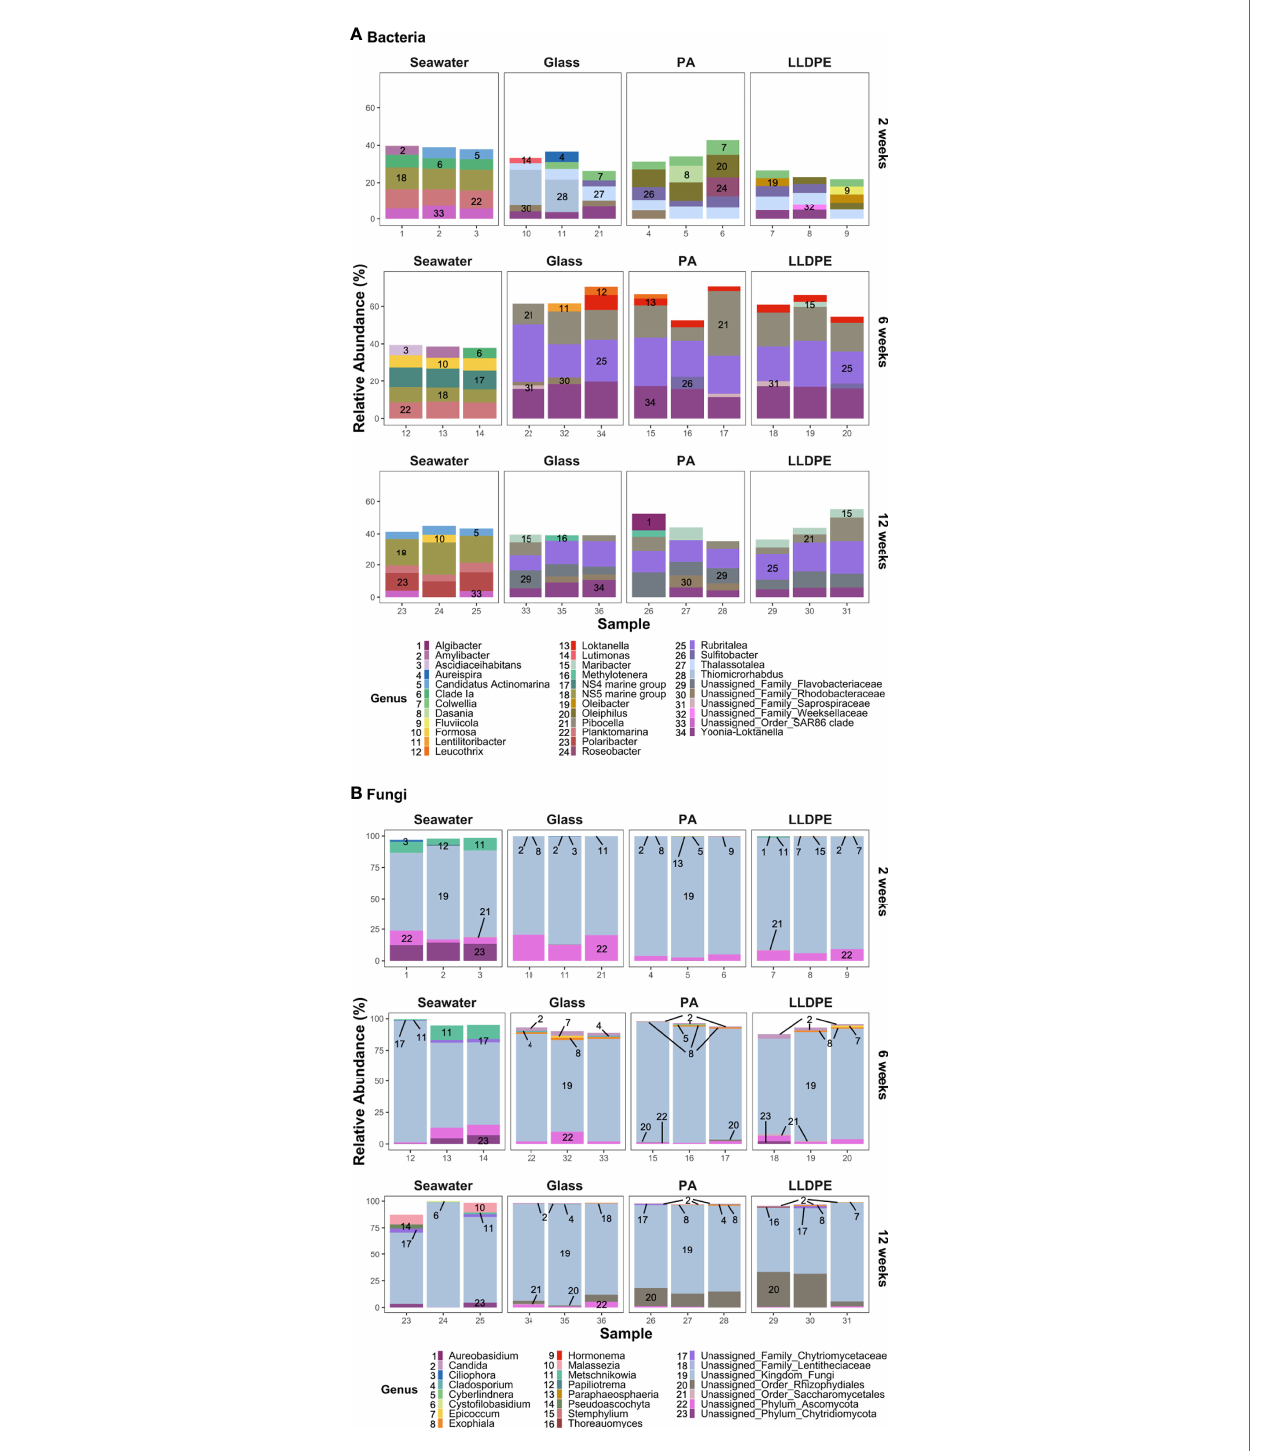
FIGURE 2 | Relative abundances (%) of the fi ve most dominant (A) bacterial and (B) fungal genera within communities in each sample on glass, nylon-6 (PA) and linear low-density polyethylene (LLDPE) and in seawater from the marine environment of Te Whakaraup ō -Lyttelton Harbour, Aotearoa-New Zealand. Each bar represents the relative abundance of the fi ve most dominant taxa within each sample from various substrates, collected at different bio fi lm ages. Each colour and corresponding number represents a particular